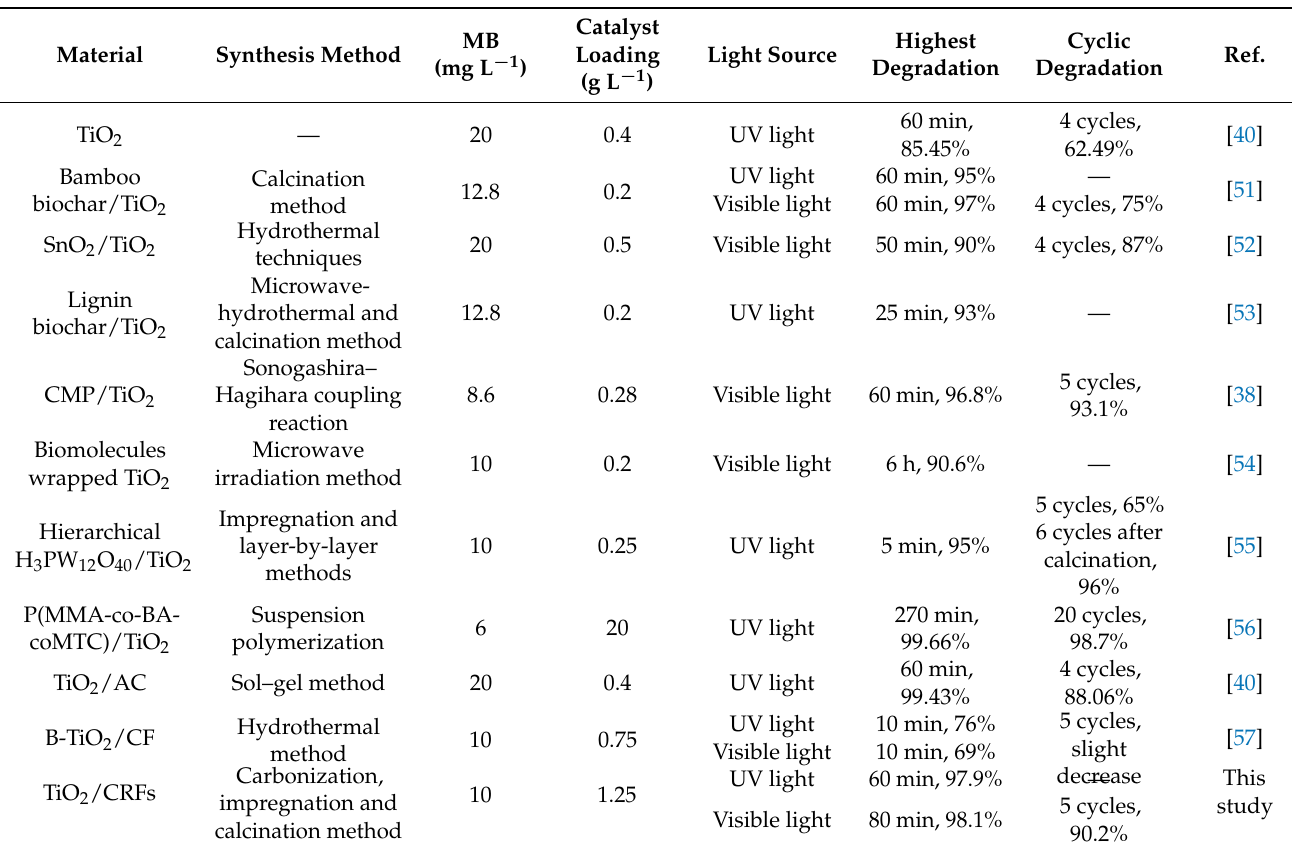
Figure 11. Image of ( a ) before and ( b ) after the photocatalytic degradation of methylene blue solution. Table 2. Research progress in degradation of MB dye by TiO 2 composite